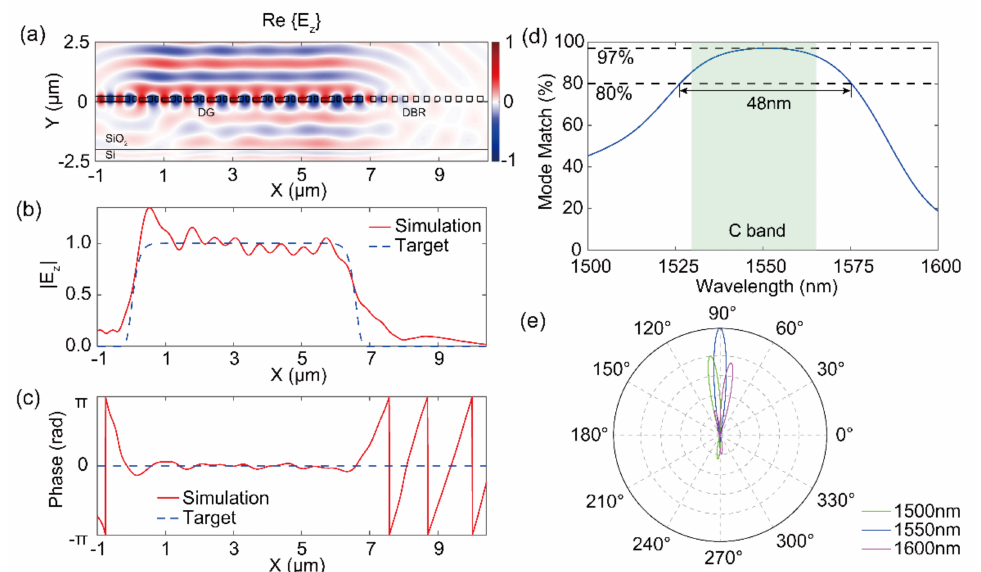
Figure 4. Performance of the grating coupler with a 10 periods DG and a DBR ( a ) The real part of E z shows the simulated radiation with the high vertical radiation and flat wavefront. ( b , c ) Comparison between the simulated ( b ) amplitude and ( c ) phase of E z for the optimized grating coupler and the target flat-top wavefront. ( d ) The mode match results of the designed structure. ( e ) The far-field radiation performance of the optimized grating